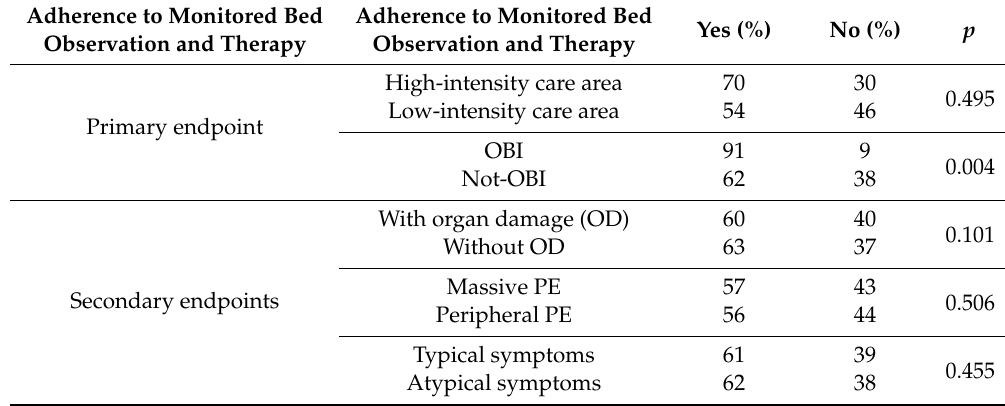
Table 4. Adherence to monitored bed observation and therapy. At the top, the analytic subgroups for the primary outcome. Below, the subgroups analyzed in the secondary